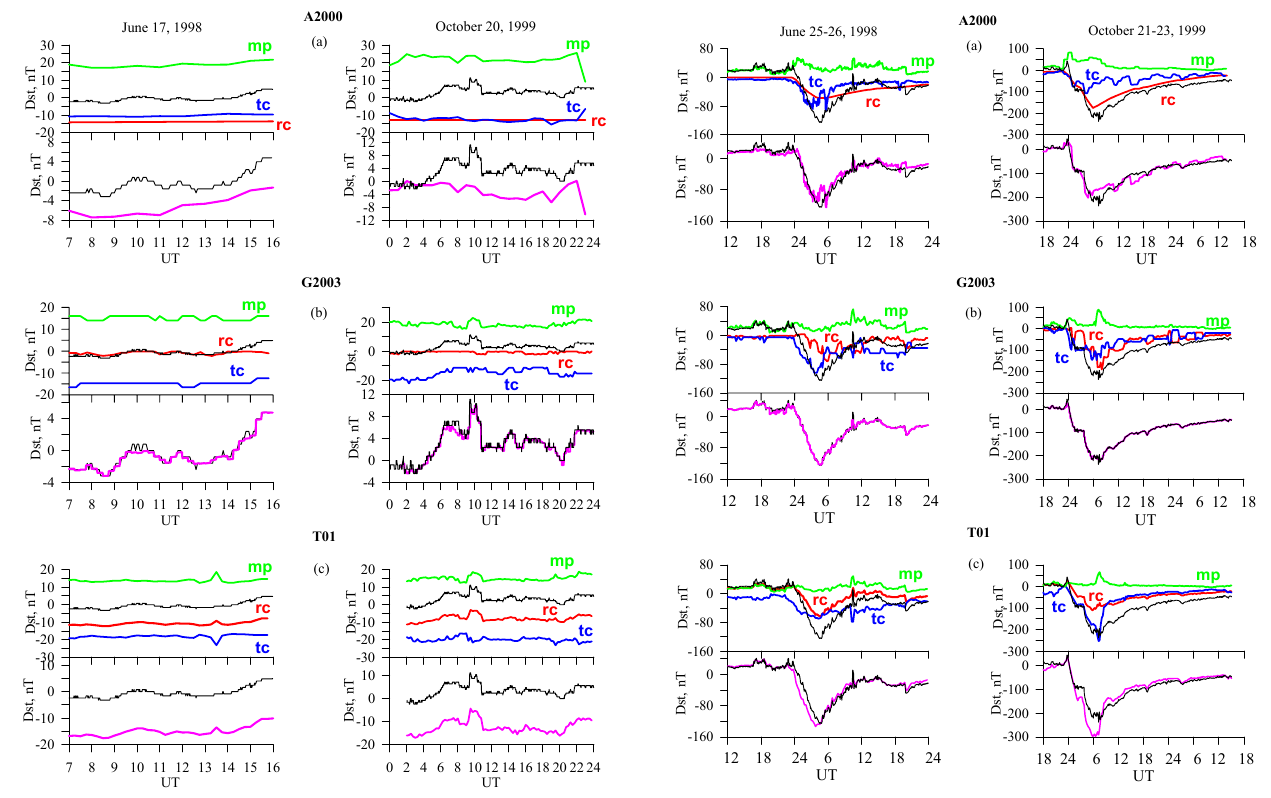
Fig. 7. Model contributions to D st and total D st during 25–26 June Fig. 6. D st index (black) and the model contributions to the quiet- 1998 and 21–23 October 1999 storm events in the same format as time magnetic field at the Earth’s equator from the magnetopause in Fig. 5. The quiet-time contributions from the different current current (green), ring current (red) and tail current (blue) (top panel) systems are subtracted from the model magnetic field together with the total observed D st (black) and modelled quiet- day variation, δH q , (purple) (bottom panel) for 17 June 1998 (left) and 20 October 1999 (right) using ( a ) A2000 paraboloid model, ( b ) G2003 event-oriented model, and ( c ) T01 model, respectively. Fig. 7. Model contributions to Dst and total Dst during June 25-26, 1998 and October 21-23, 1999 storm Fig. 6. Dst index (black) and the model contributions to the quiet-time magnetic field at the Earth’s equator events in the same format as in Figure 5. The quiet-time contributions from the different current systems are from the magnetopause current (green), ring current (red) and tail current (blue) (top panel) together with the subtracted from the model magnetic field variations. total observed Dst (black) and modelled quiet-day variation, δH q , (purple) (bottom panel) for June 17, 1998 (left) and October 20, 1999 (right) using (a) A2000 paraboloid model, (b) G2003 event-oriented model, and (c) T01 model, respectively.